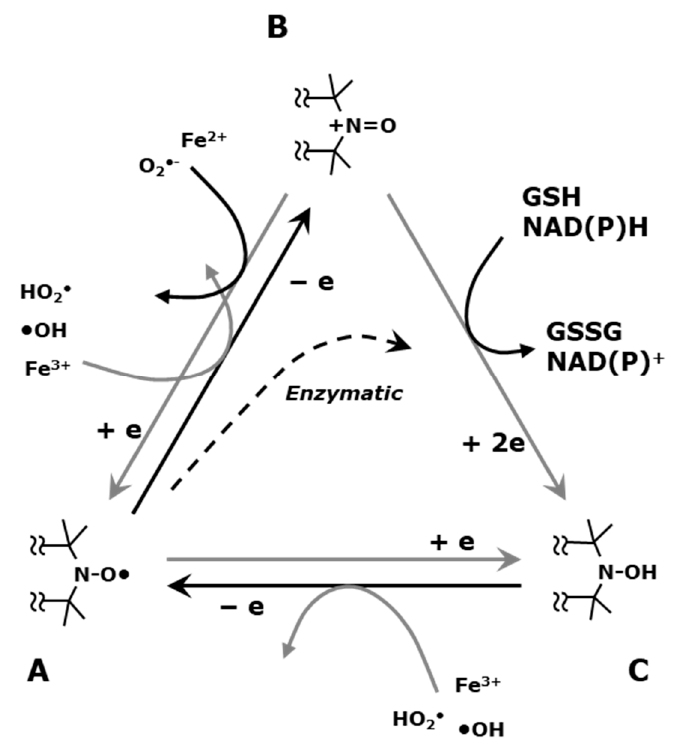
Figure 9. Redox transformations of nitroxyl radicals in ( A ) the free radical state, ( B ) the oxoammo- nium cation, and ( C ) the hydroxylamine. The nitroxyl radical could be one-electron oxidized to be- come the corresponding oxoammonium cation form. The oxoammonium cation could readily be back to nitroxyl radical by one-electron reduction, or two-electron reduced to hydroxylamine form by receiving a hydrogen atom from hydrogen donor, such as NAD(P)H and/or GSH. The hydrox- ylamine could be one-electron oxidized to be nitroxyl radical form. The figures were partly modified from our previous reports [97].